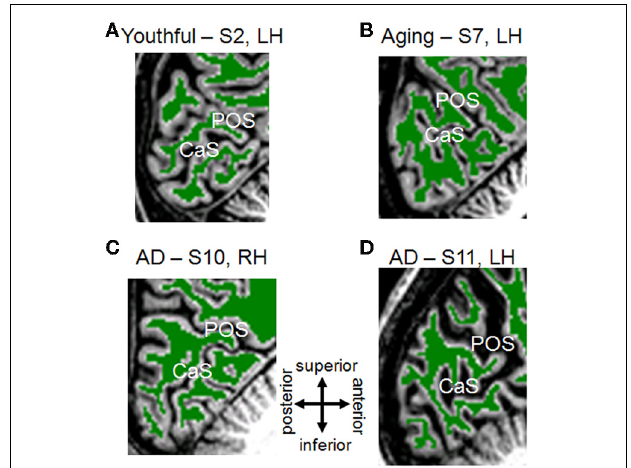
FIGURE 1 | White/Gray matter segmentation for young, healthy aging, and mild Alzheimer’s disease subjects. Each panel is a T1-weighted 3D MPRAGE image showing a sagittal slice near the midline of the brain, cropped to the occipital lobe with the calcarine sulcus (CaS; home to V1) and the parietal-occipital sulcus (POS) visible. Green-colored overlay represents white matter identified by an automated algorithm (Teo et al., 1997) and adjusted by hand-editing to minimize segmentation errors (Dougherty et al., 2003). Gray regions are gray matter, and white regions are white matter not segmented in the cerebellum. Gray matter is grown from the boundary of the white matter and bounded by the cerebral spinal fluid (CSF; black adjacent to gray matter). Portions of skull and dura mater are also visible. (A) Youthful Subject 2, left hemisphere. (B) Aging Subject 7, left hemisphere. (C) Mild Alzheimer’s disease Subject 10, right hemisphere. (D) Mild Alzheimer’s disease Subject 11, left hemisphere. Compare AD-S10’s intact anatomy to the visibly altered visual field maps from this subject in Figure 2 . Note also the reverse pattern for AD-S11, who has grossly intact map sizes, but more strikingly increased CSF-filled